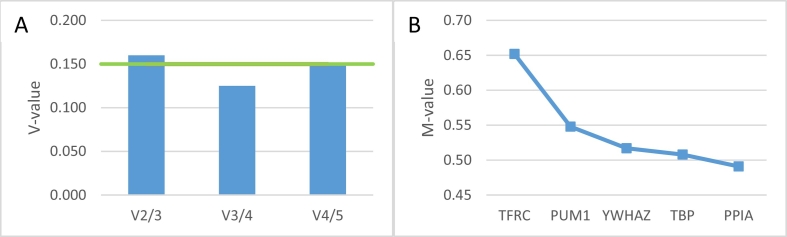
GeNorm analysis. A) Candidate reference gene (RG) variability (V-values) indicating the variability between 2 or 3 RGs (V2/3), 3 or 4 RGs (V3/4), and 5 or 6 RGs (V4/5). The green line indicates the cut-off value (0.150). B) Average expression stability of remaining candidate reference genes (M-value). (For interpretation of the references to colour in this figure legend, the reader is referred to the web version of this article.)